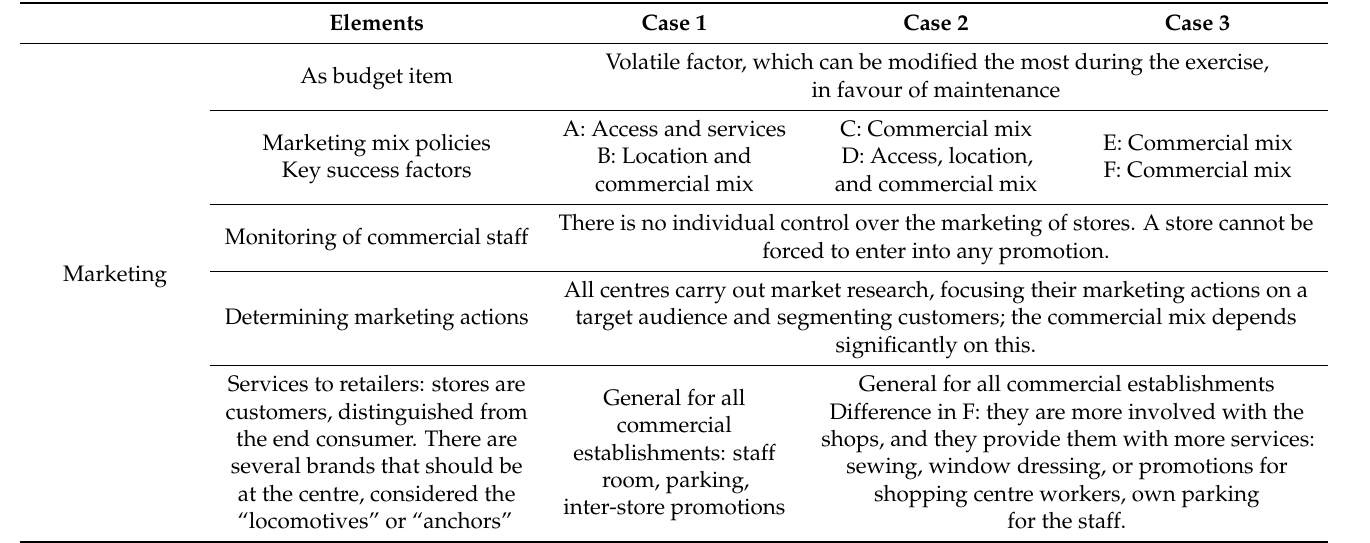
Table 6. Marketing management in shopping centres 1